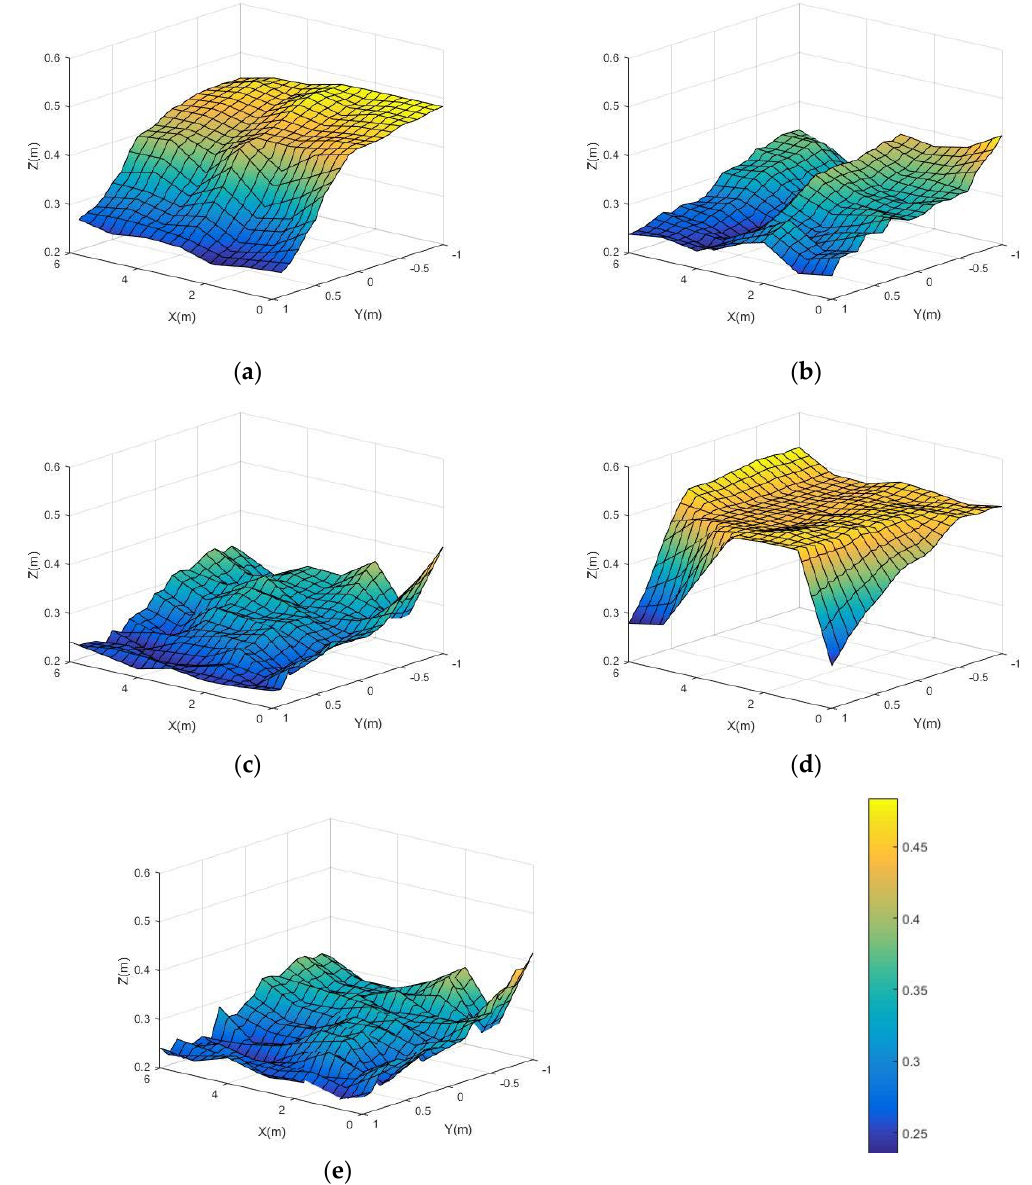
Figure 7. Bathymetric and topographic digital model terrain of the beach over the laboratory tests: ( a ) t = 0 min; ( b ) t = 1200 min; ( c ) t = 1590 min; ( d ) t = 1590 min (A.2); ( e ) t = 2790 min.